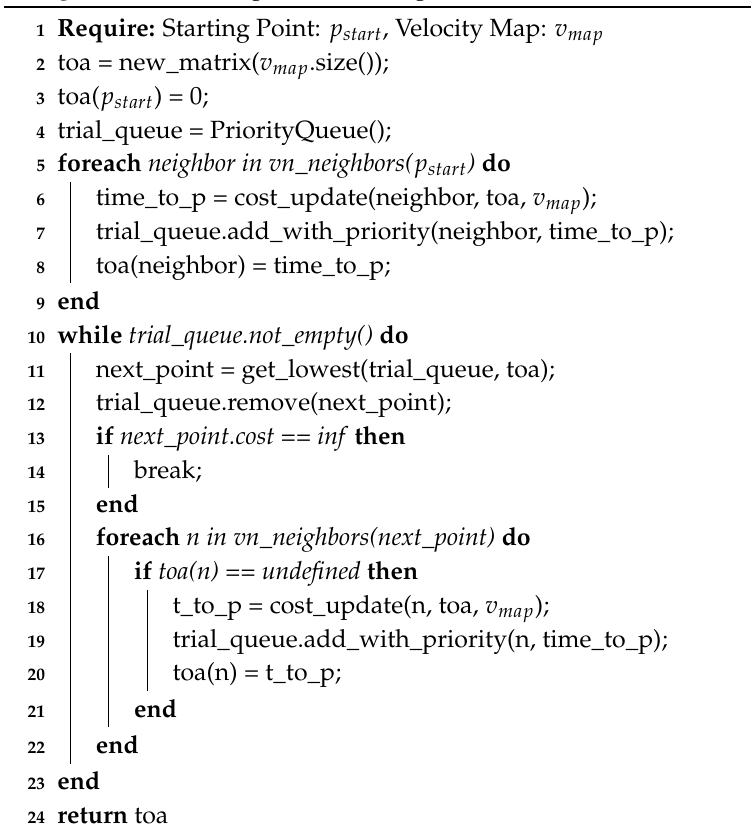
Algorithm 7: Solving Fast Marching Method (FMM) Time of Arrival